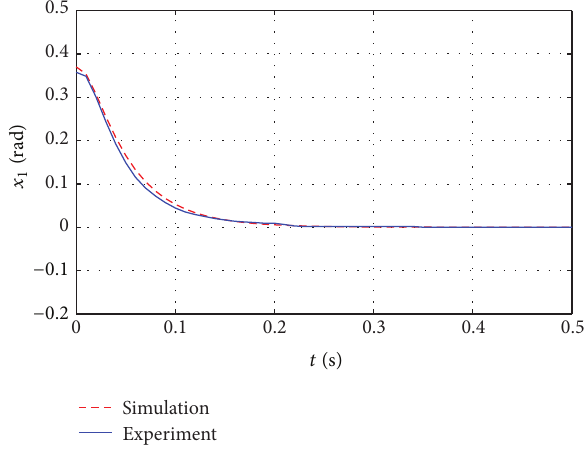
Figure 6: The state variable 𝑥 1 .